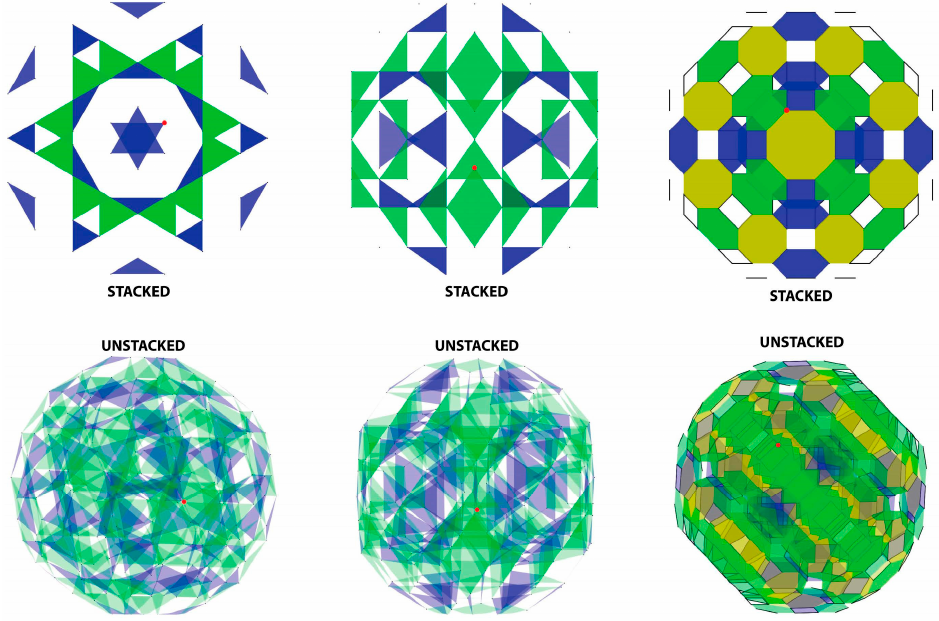
Figure 7. Using stacking-unstacking to enhance the exploration of complex visualizations.